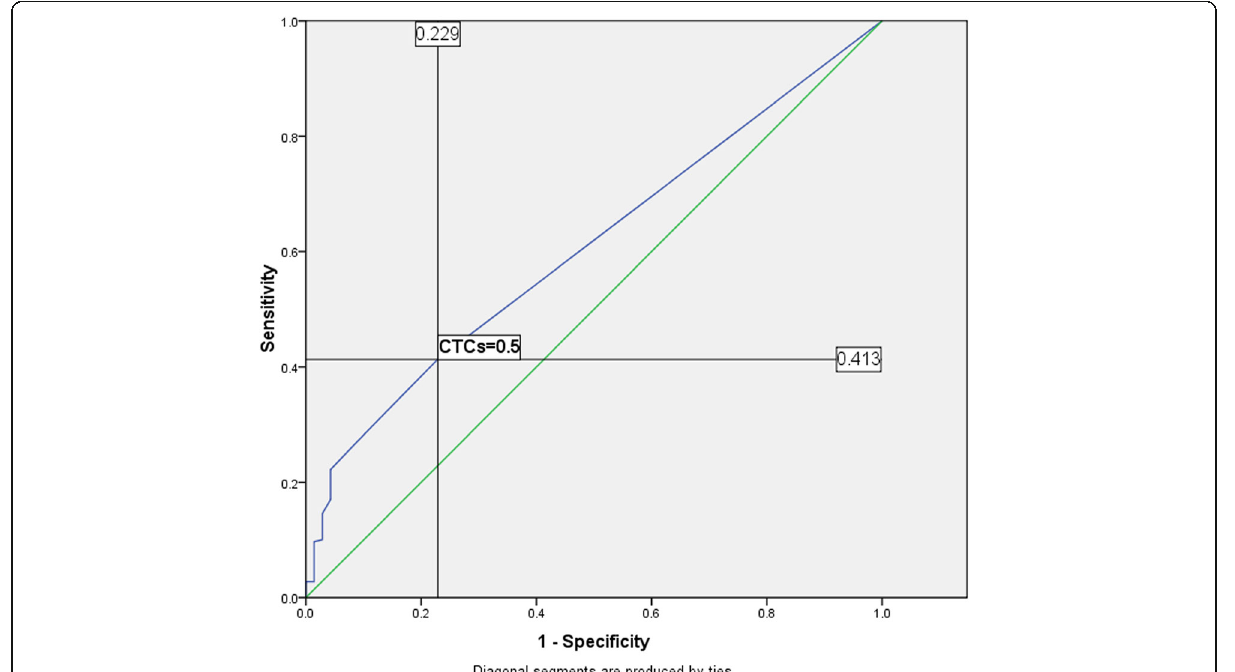
Fig. 2 ROC curve of NPC-(III and IV) based on